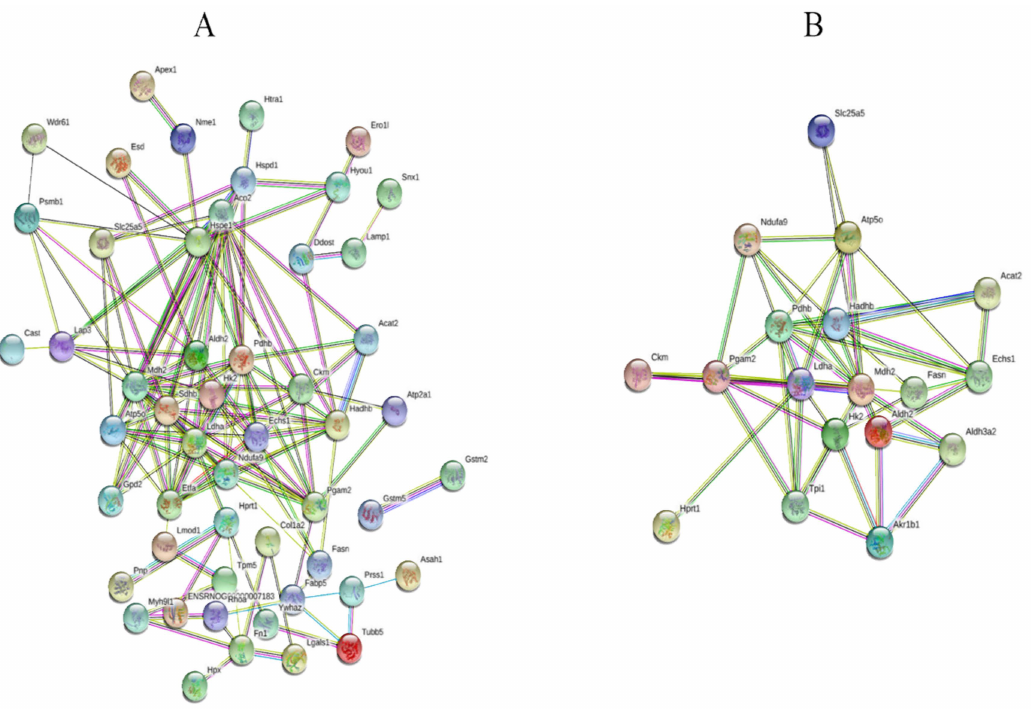
Figure 5. Protein interaction analysis of di ff erently-expressed proteins by STRING. ( A ) All the di ff erently-expressed proteins in the mangiferin treated group, ( B ) the proteins returned to normal pretreated with mangiferin.